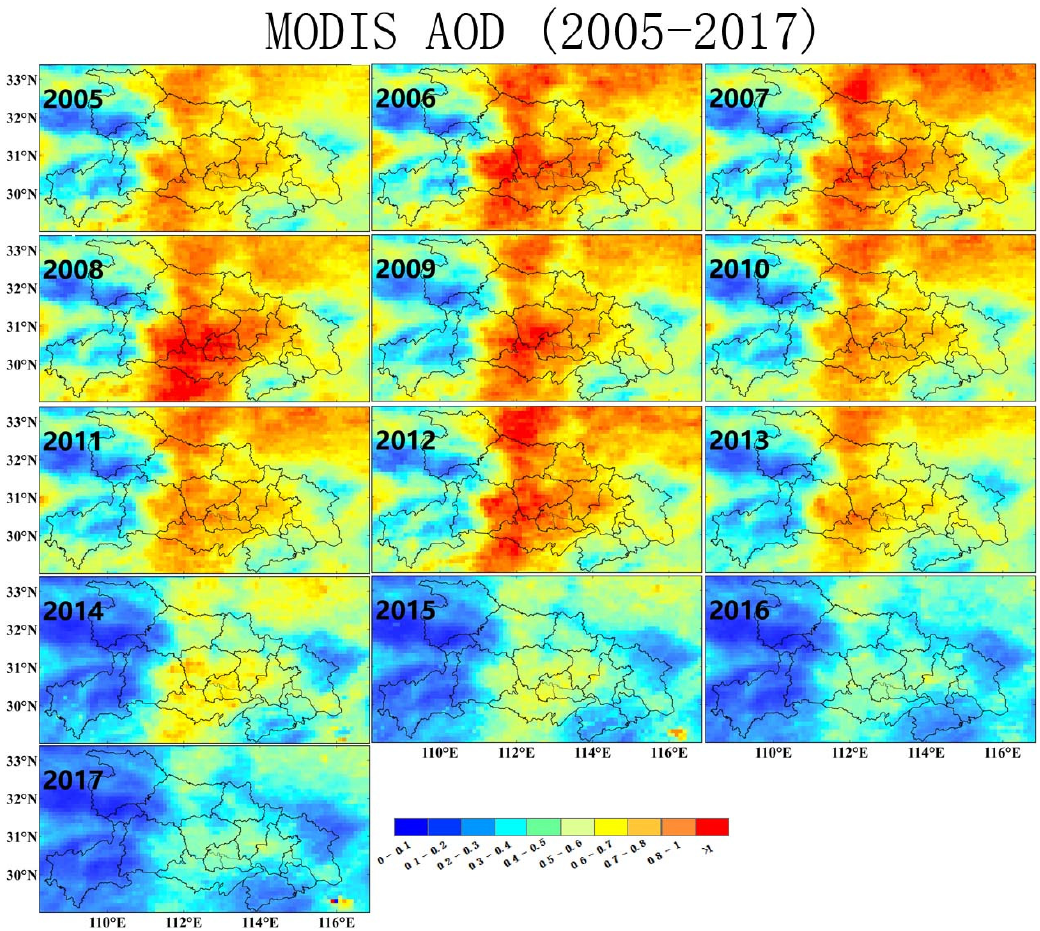
Figure 8. Spatial and temporal distribution of annual moderate resolution imaging spectroradiometer (MODIS) aerosol optical depth (AOD) at 550 nm over Hubei province during 2005–2017.